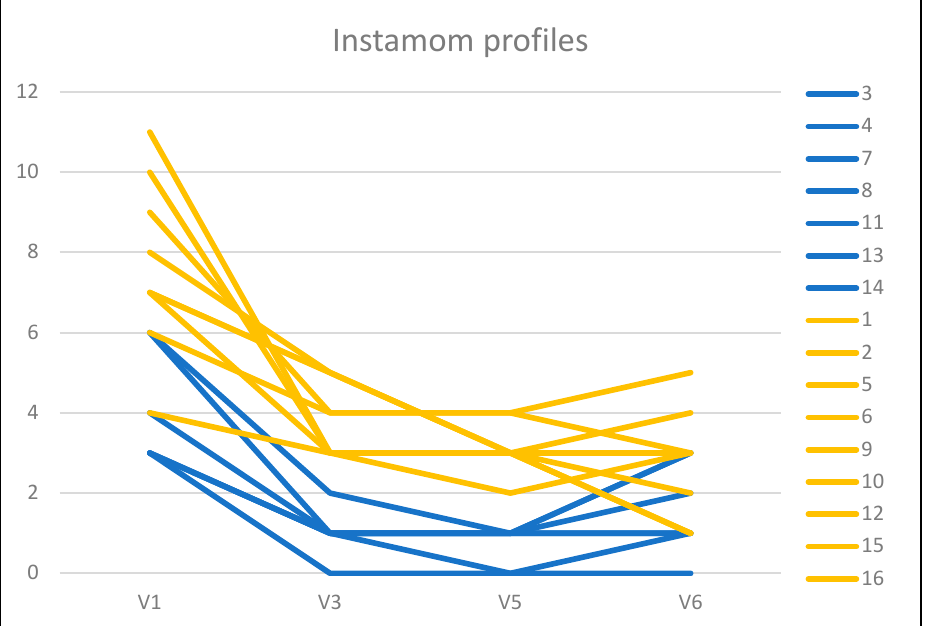
Figure 1 graphically represents the profiles of the Instamoms. It can be seen that the frequency of use of minors is lower in the profiles of the Instamoms of cluster 1 (blue lines) compared to the profiles of the Instamoms of cluster 2 (yellow lines). Finally, we compared the impact of the posts between the two clusters, obtaining significance ( p = 0.030) in the case of the situation in which at least one minor is present, but not in the other two situations in which the mother appears alone ( p = 0.091) or the mother appears in the company of other adults ( p = 0.118).